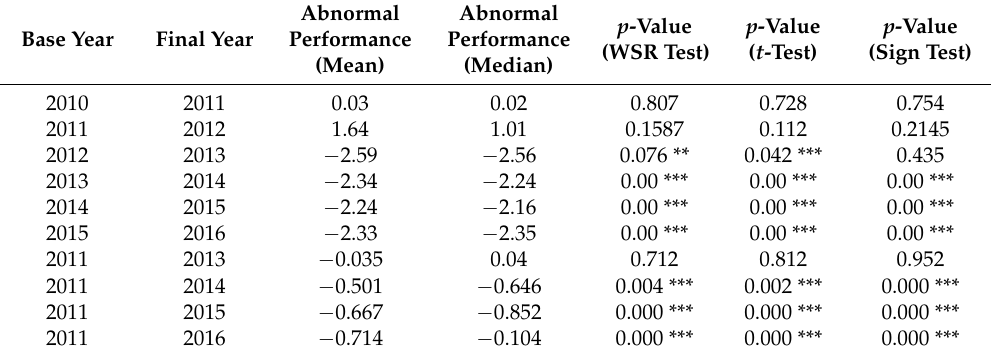
Table 4. Alternative test: Abnormal performance in market valuation, one-to-one matched by size and